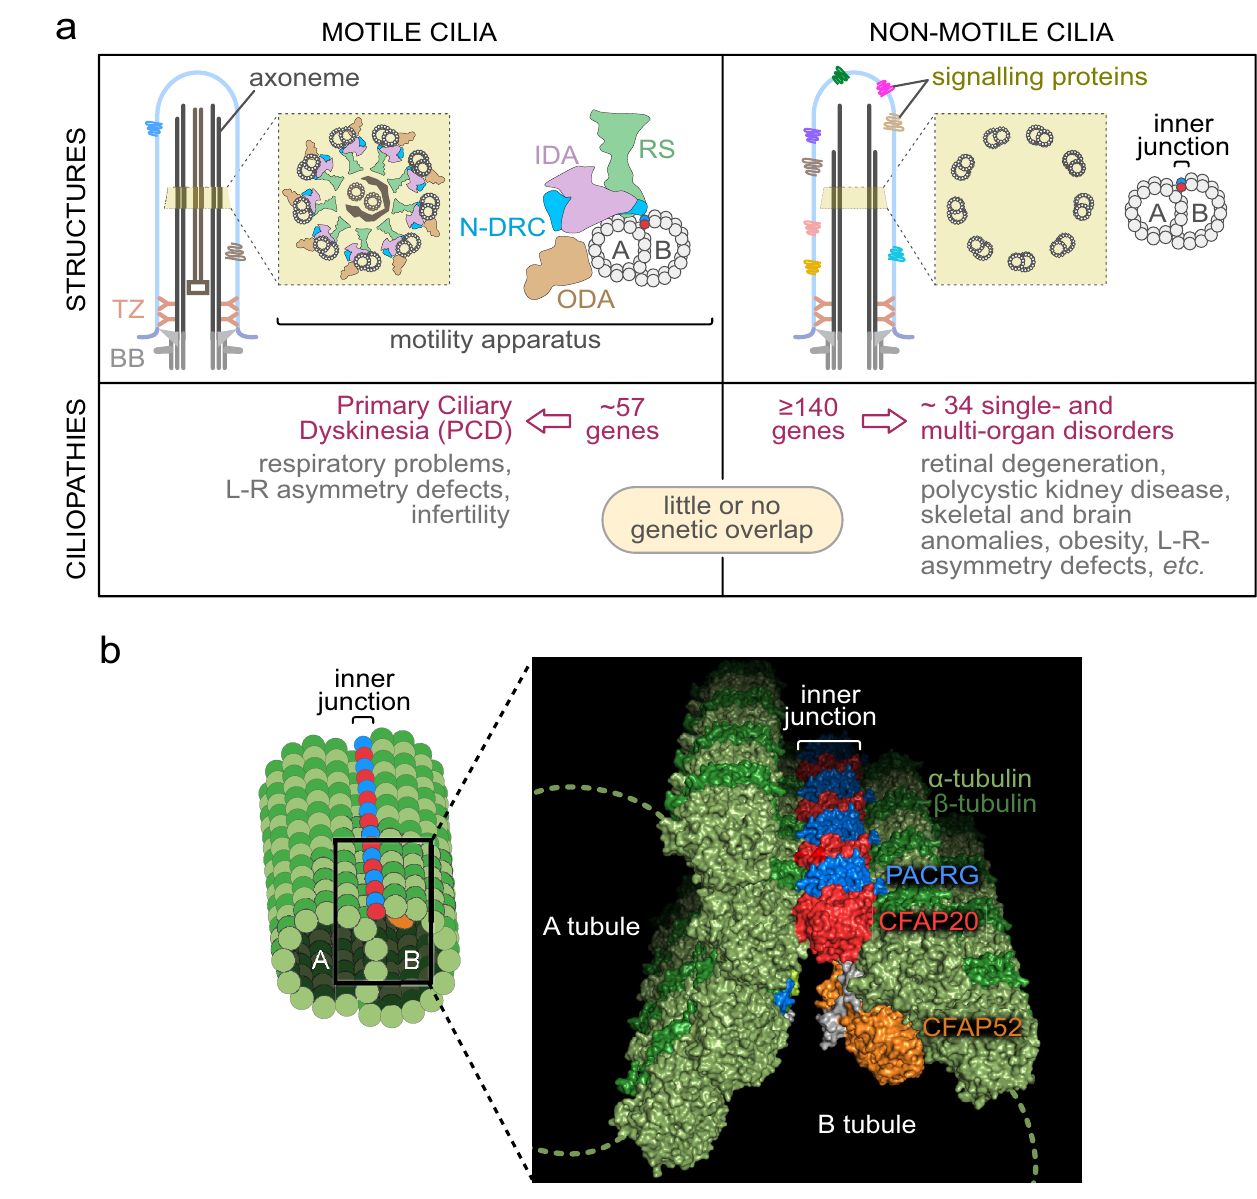
Fig. 1 | The two principal classes of ciliopathies are considered to be mutually exclusive:theyaffectthefunctionsofmotileornon-motile(primary)cilia,and they have little to no genetic overlap. a Functional modules in motile cilia encompassatleast57proteins,andincludesubunitsoftheInnerDyneinArm(IDA) and Outer Dynein Arm (ODA), which confer motility, as well as subunits within radial spokes (RS) and the Nexin-Dynein Regulatory Complex (N-DRC), which regulate motility. At least 140 proteins are implicated in a wide array non-motile